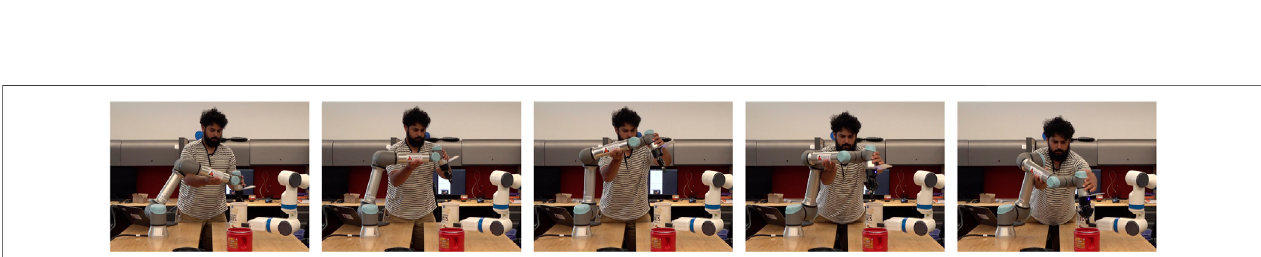
FIGURE 13 | A human teacher demonstrating the pick-and-place task to a UR5e robot.